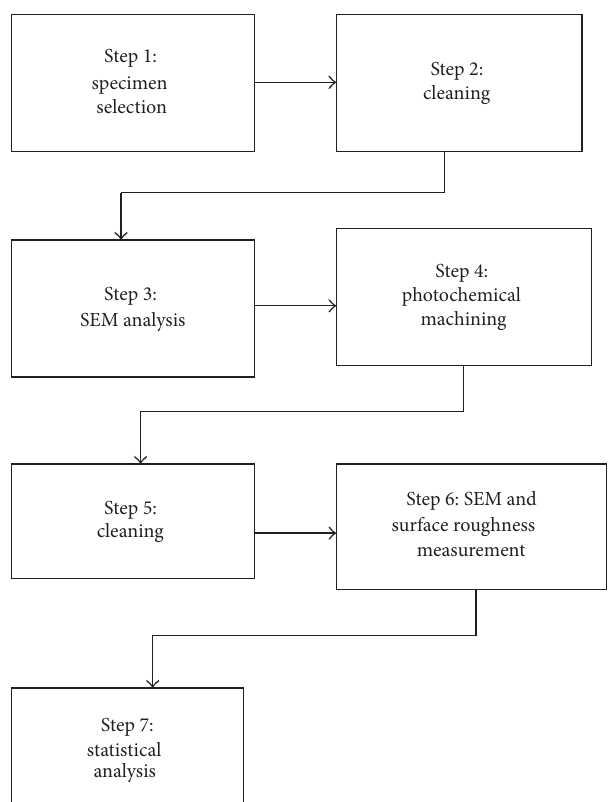
Figure 4: Flow chart of PCM experimentation.